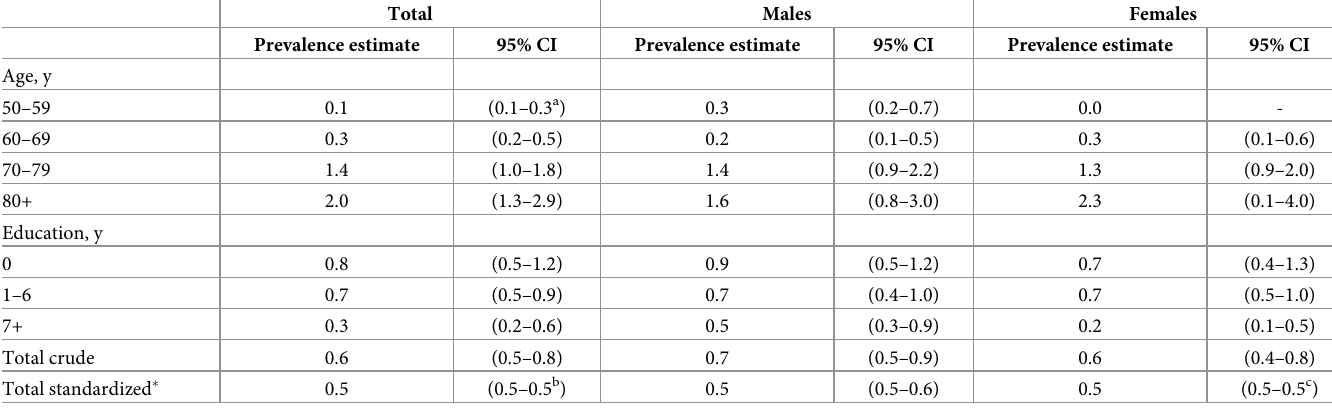
Table 2. Prevalence estimates of possible vascular dementia by sex, age, and education from the MHAS